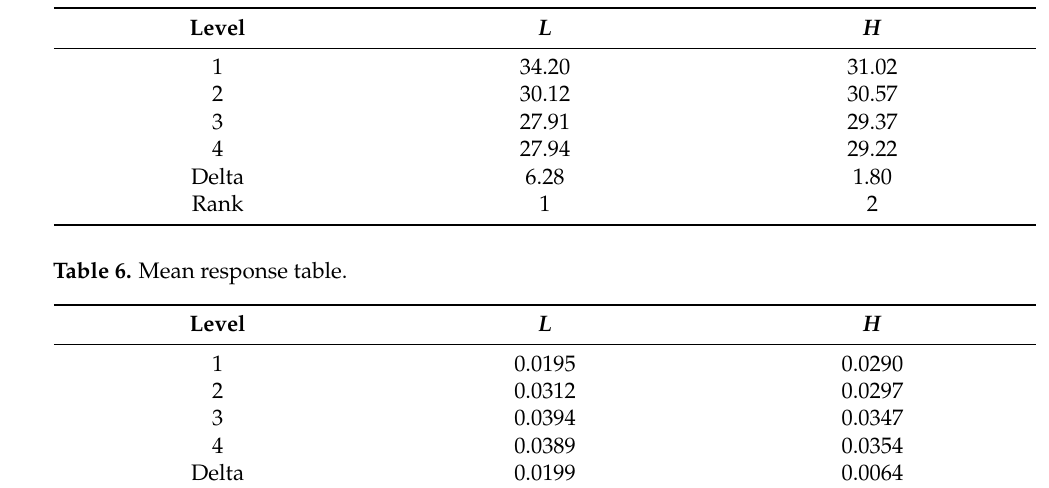
Table 5. SNR response table (STB).